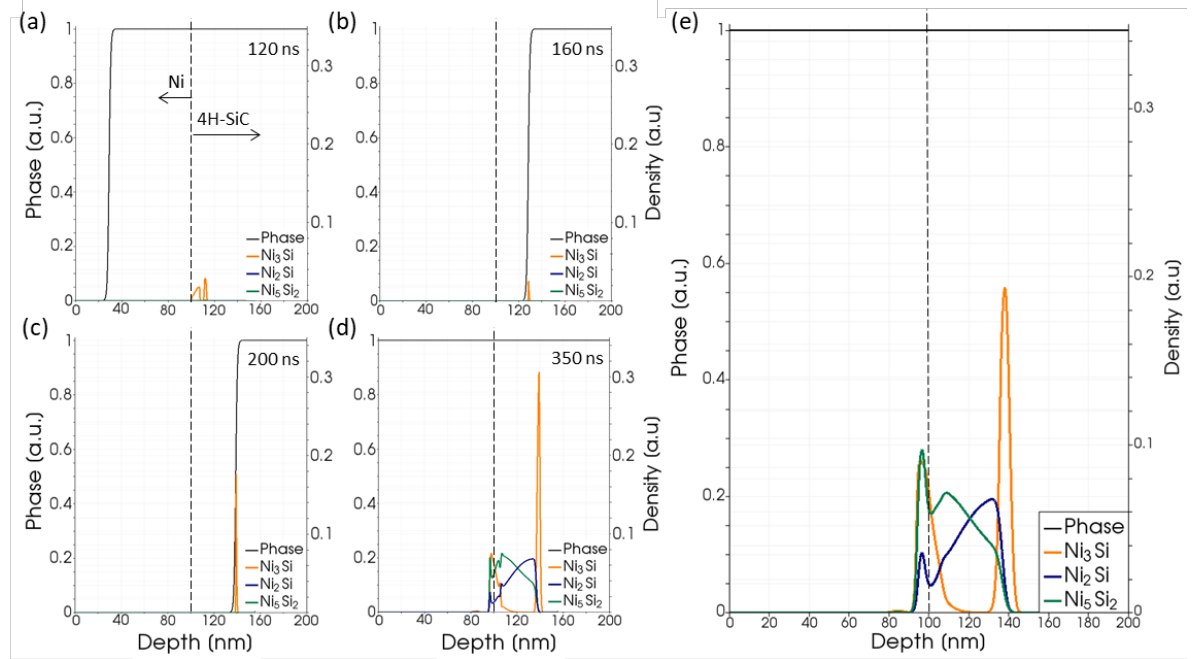
Figure 7. Phase field (black line and left axis with interface parameters 𝜏 𝜑 = 4.83 × 10 −9 s and 𝑊 = 1 nm) and simulated local density (right axis scale) of the Ni 3 Si (dark yellow lines), Ni 5 Si 2 class (dark green lines) and Ni 2 Si (blue lines) for a PLA laser annealing process with ∆𝑡 𝑝𝑢𝑙𝑠𝑒 = 160 ns and fluence of 3. 6 J/cm 2 . Snapshots ( a – d ) are taken at t = 120, 160, 200, 350 ns, while ( e ) is taken at the end of the simulation. The phase function 𝜑 is plotted as a black line. The initial system is a deposited 100 nm thick Ni film on a 4H-SiC substrate (the original interface depth is indicated by a dashed black line) [58].